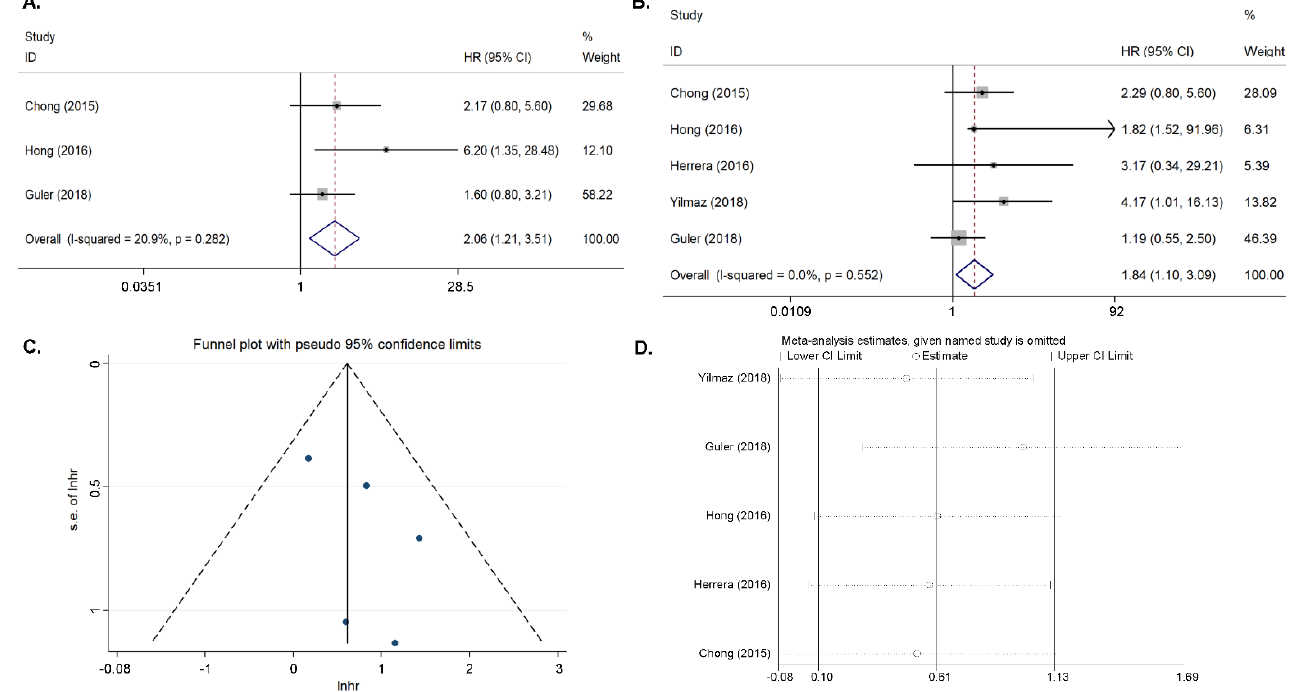
Figure 2. Results for the primary MTV and TLG for DFS. ( A ) Forest plots of the HRs for DFS with MTV. ( B ) Forest plots of the HRs for DFS with TLG. ( C ) Begg’s funnel plot for TLG. ( D ) Sensitivity analysis of the influence of each individual study on the pooled HR for TLG.